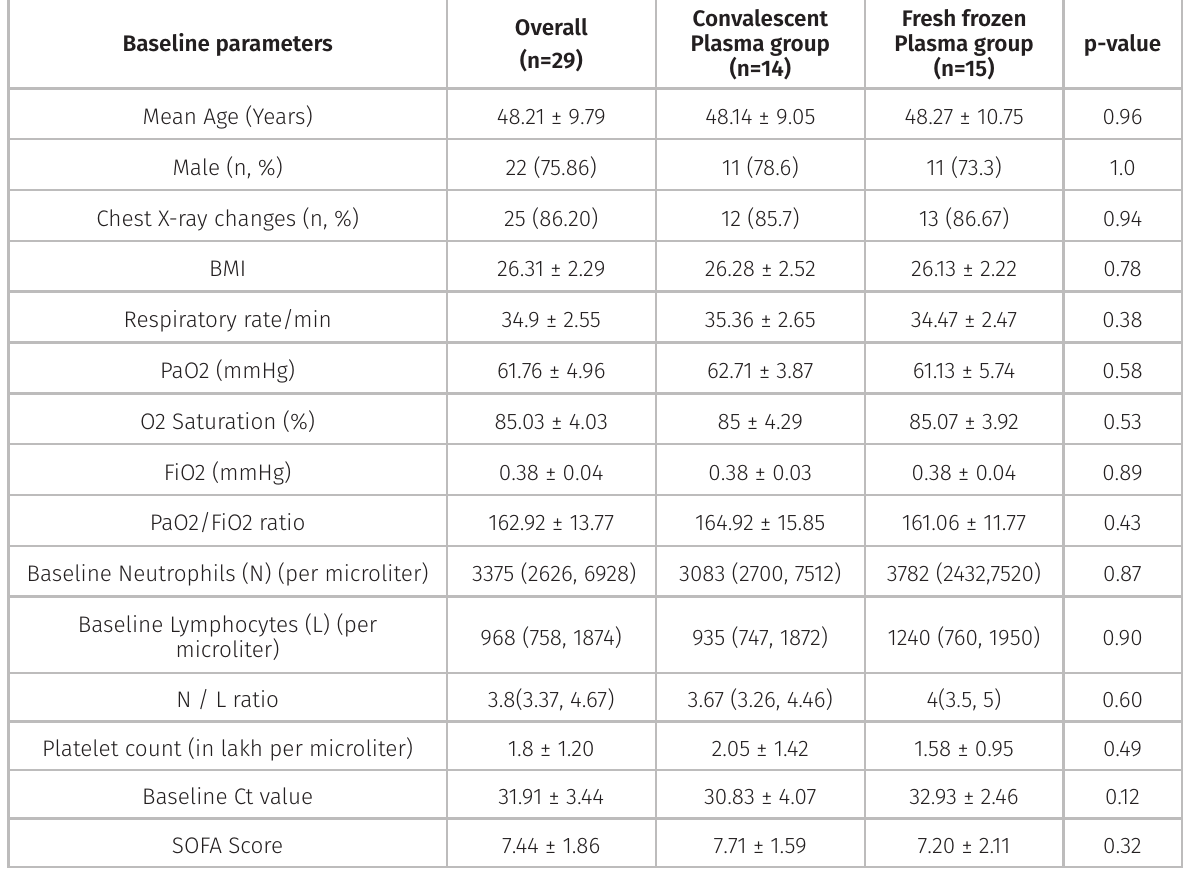
Table I. Baseline characteristics of patients in the